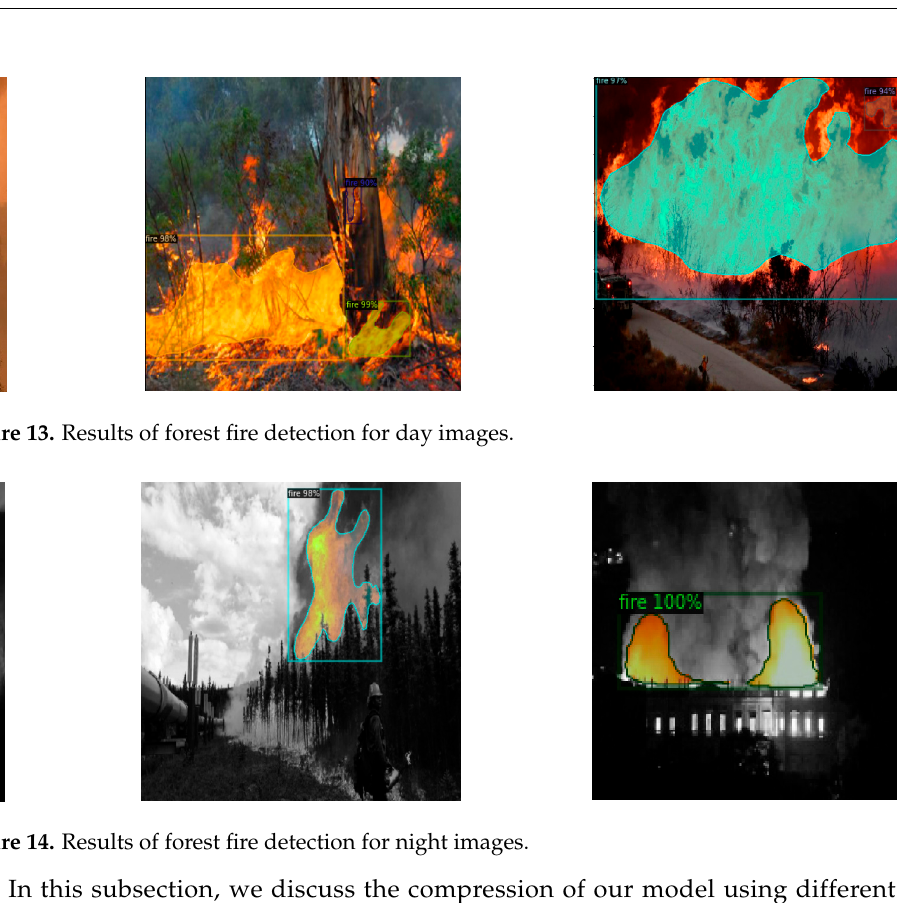
Table 7. Quantitative results of fire detection. Algorithm